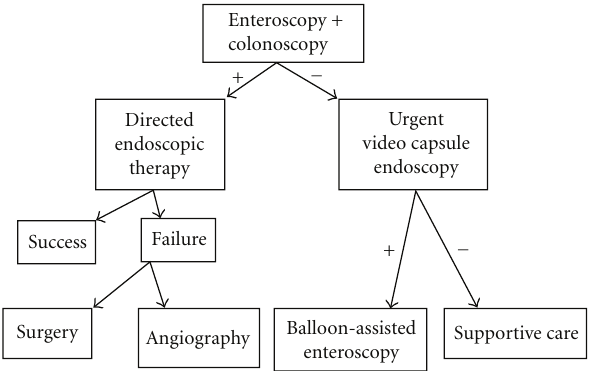
Figure 1: Decision algorithm for the initial evaluation of VAD patients with obscure-overt gastrointestinal bleeding.